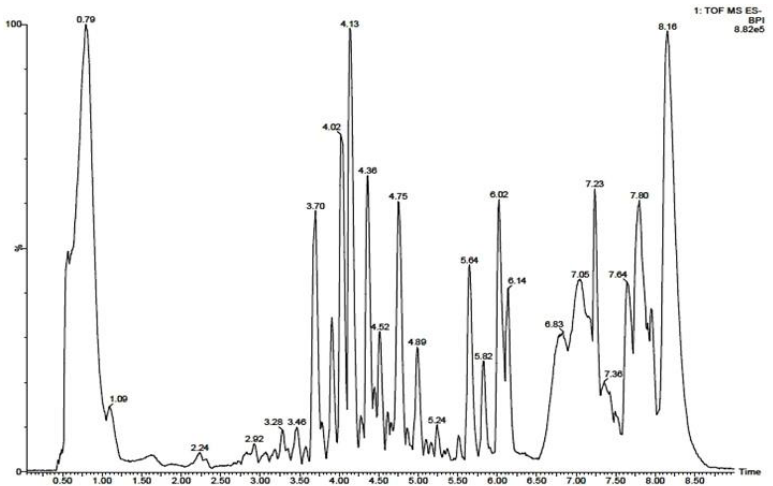
Figure 1. Total ion chromatogram of O. indicum Vent. Wild root bark (OIM) extract subjected to UPLC-Q-TOF-MS analysis (Data from own publication